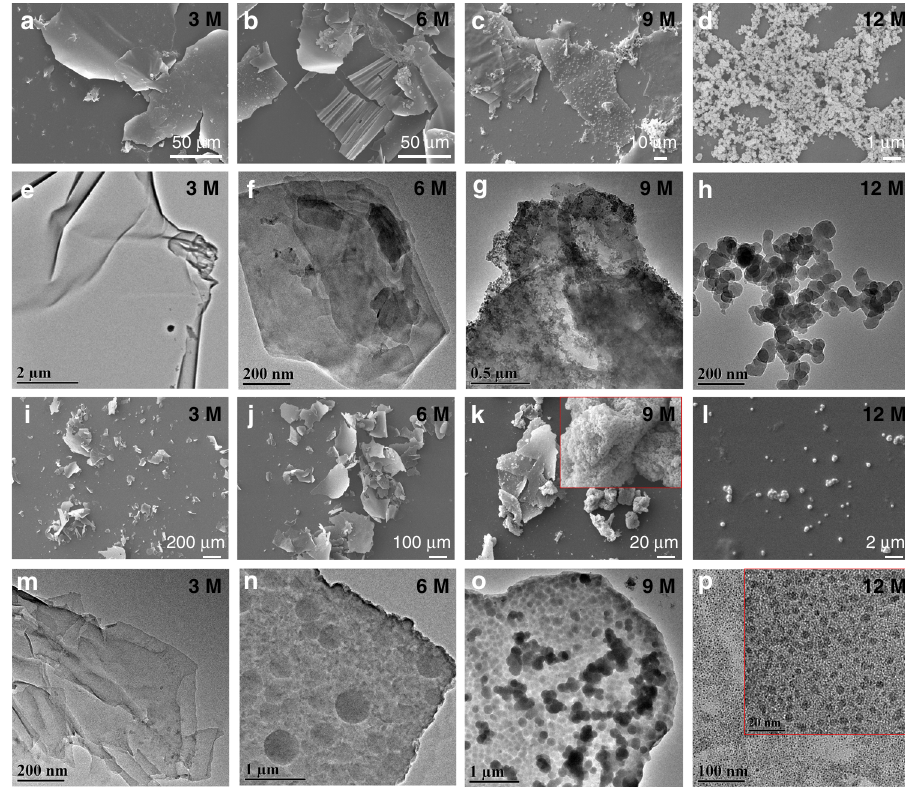
Fig. 4 SEM and TEM images of COFs obtained at different acetic acid concentrations. a – d SEM images of FS-COM-1; e – h TEM images of FS-COM-1; i – l SEM images of FS-COM-2; m – p TEM images of FS-COM-2. Enlarged views of k and p are shown in the inserted red